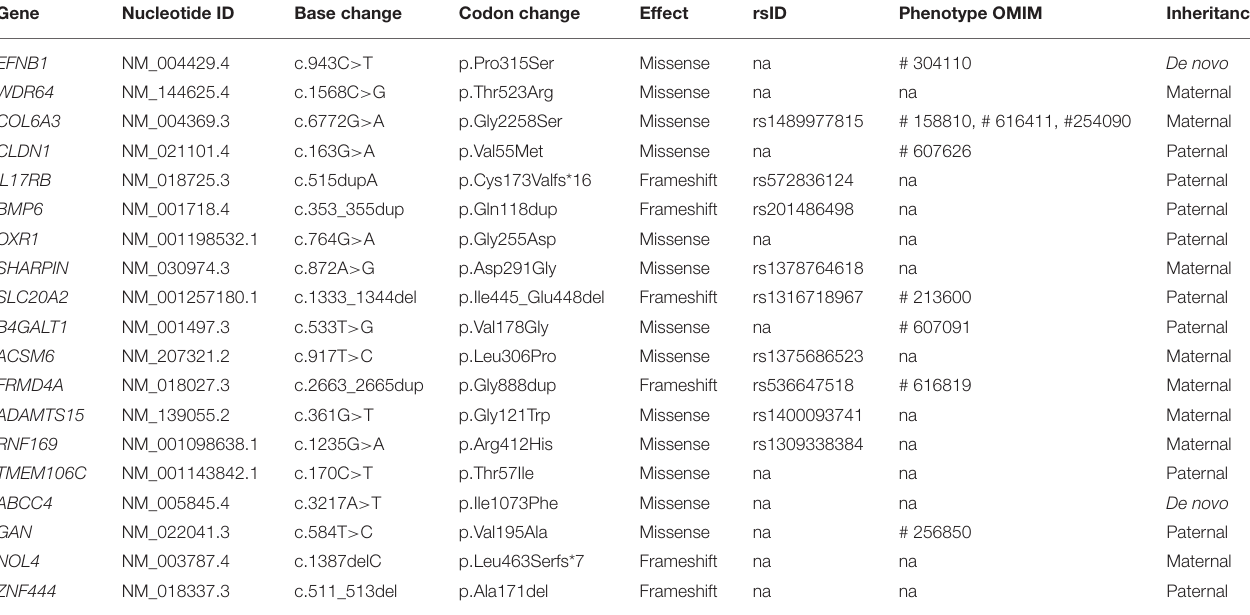
TABLE 1 | Summary of 21 rare variants as a candidate cause of schizencephaly and global developmental delay identified by trio-based exome